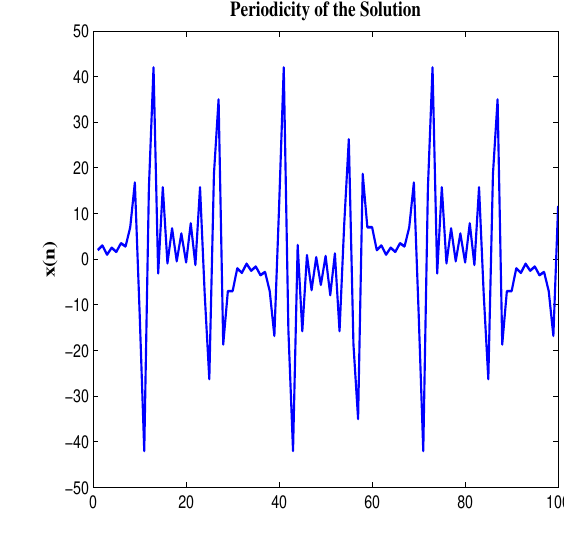
Figure 1: Local Stability of the Equilibrium.